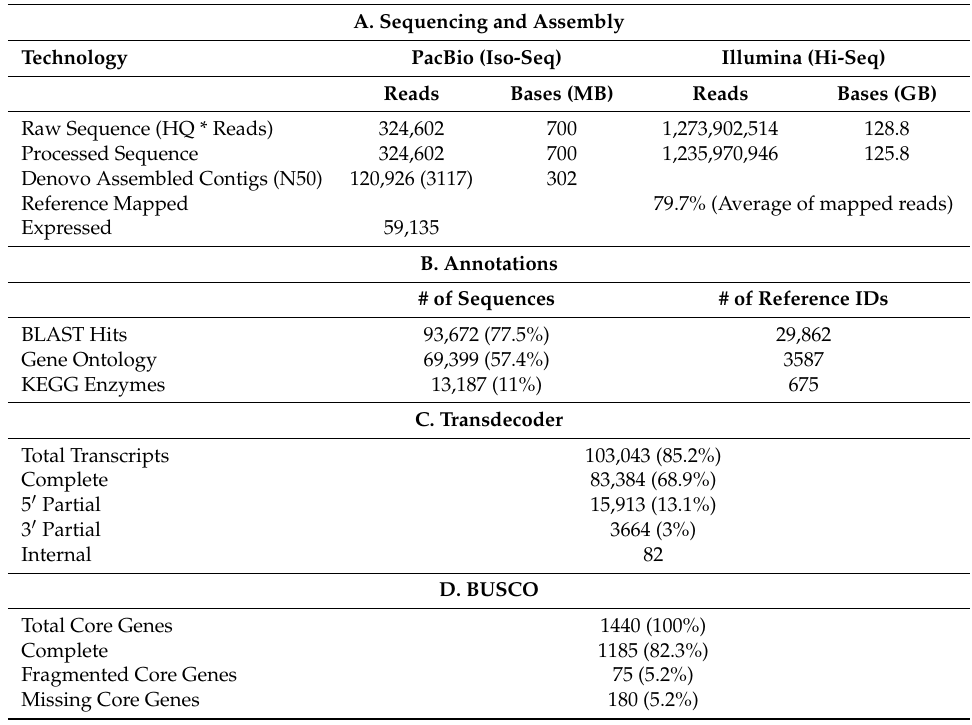
Table 1. Quantitative summary of transcriptome along with annotations ( A ) sequencing and assembly; ( B ) functional annotation; ( C ) translation summary of the transcriptome; and, ( D ) completeness assessment of the